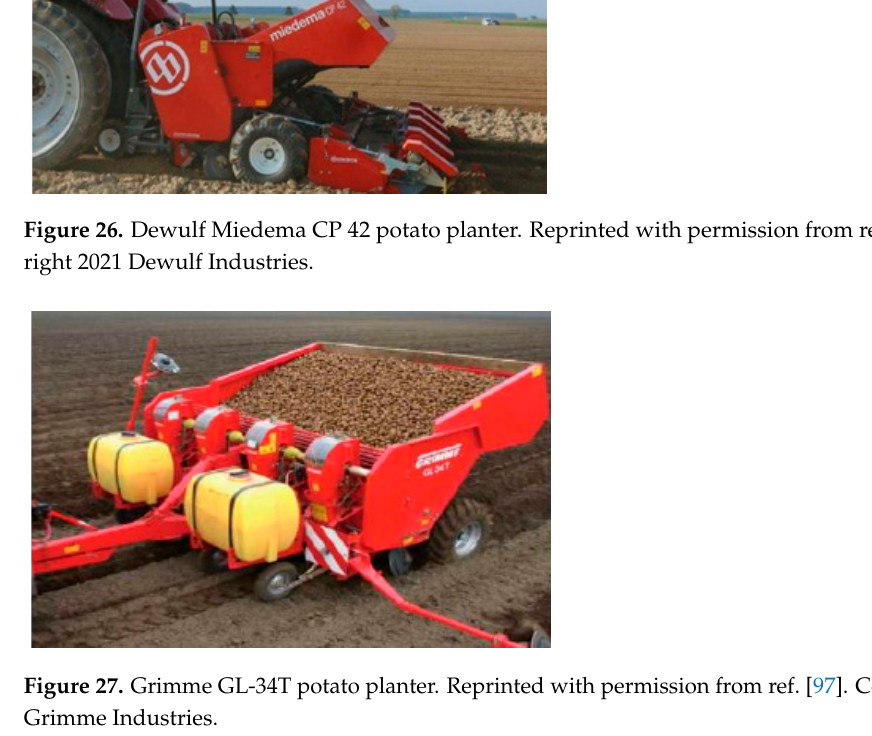
Figure 27. Grimme GL-34T potato planter. Reprinted with permission from ref. [97]. Copyright 2018 Grimme Industries.